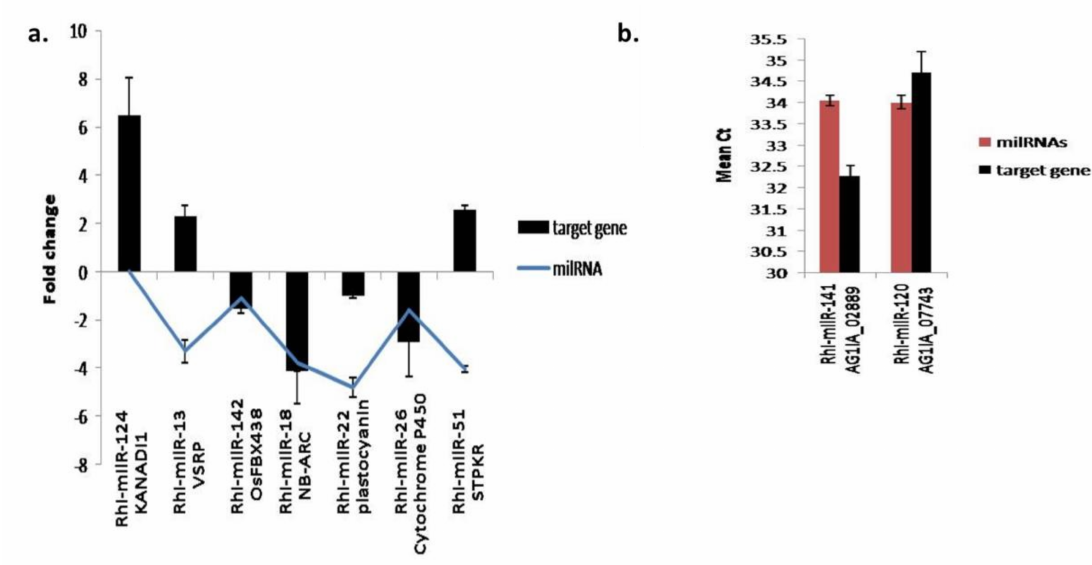
Figure 6. Expression analysis of target genes ( a ) qRT-PCR expression analysis of fungal milRNAs and their respective plant target genes. ( b ) qRT-PCR expression analysis of fungal milRNAs and their respective fungal target